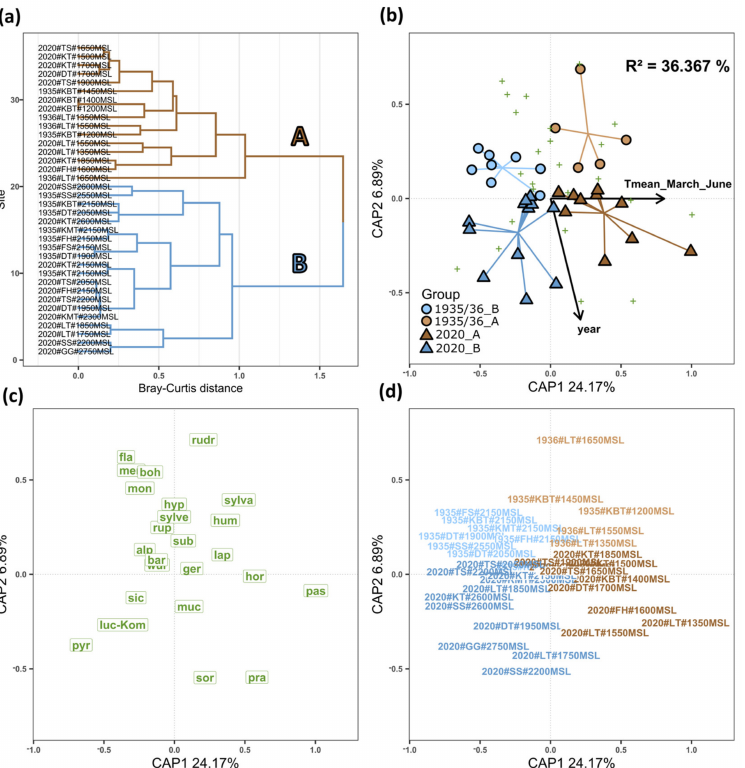
Figure 4. Analyses of bumblebee community composition of sampling units. ( a ) Cluster analysis (Hierarchical Clustering, method = “ward.D2”) and the clusters (A = brown and B = blue) extracted at Bray-Curtis distance = 1.5. ( b ) Ordination biplot of CAP modeling mean annual spring temperature and sampling period as constraints. Each point represents the community composition of one sampling unit, while colors and shapes indicate the four cluster groups (light colored circles = 1935/1936, dark colored triangles = 2020). Vectors indicate correlation of numeric values of mean annual spring temperature (“Tmean_March_June”) and sampling year (“year”) with community composition of sampling units. Values on axes refer to the percentage of explained variance. Name labels of sampling units, in reference to positions in ( b ), are shown in ( d ). Green crosses in ( b ) refer to the position of the species in the reduced ordination space, whose labels are shown in ( c